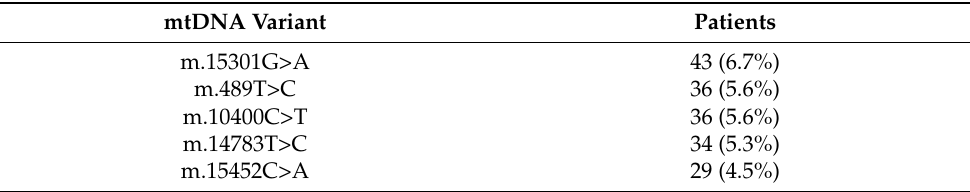
Table 2. Top-5 most frequent non-ancestral point variants. Columns from left to right: mtDNA sequence variant, variant frequency (number of patients and frequency).